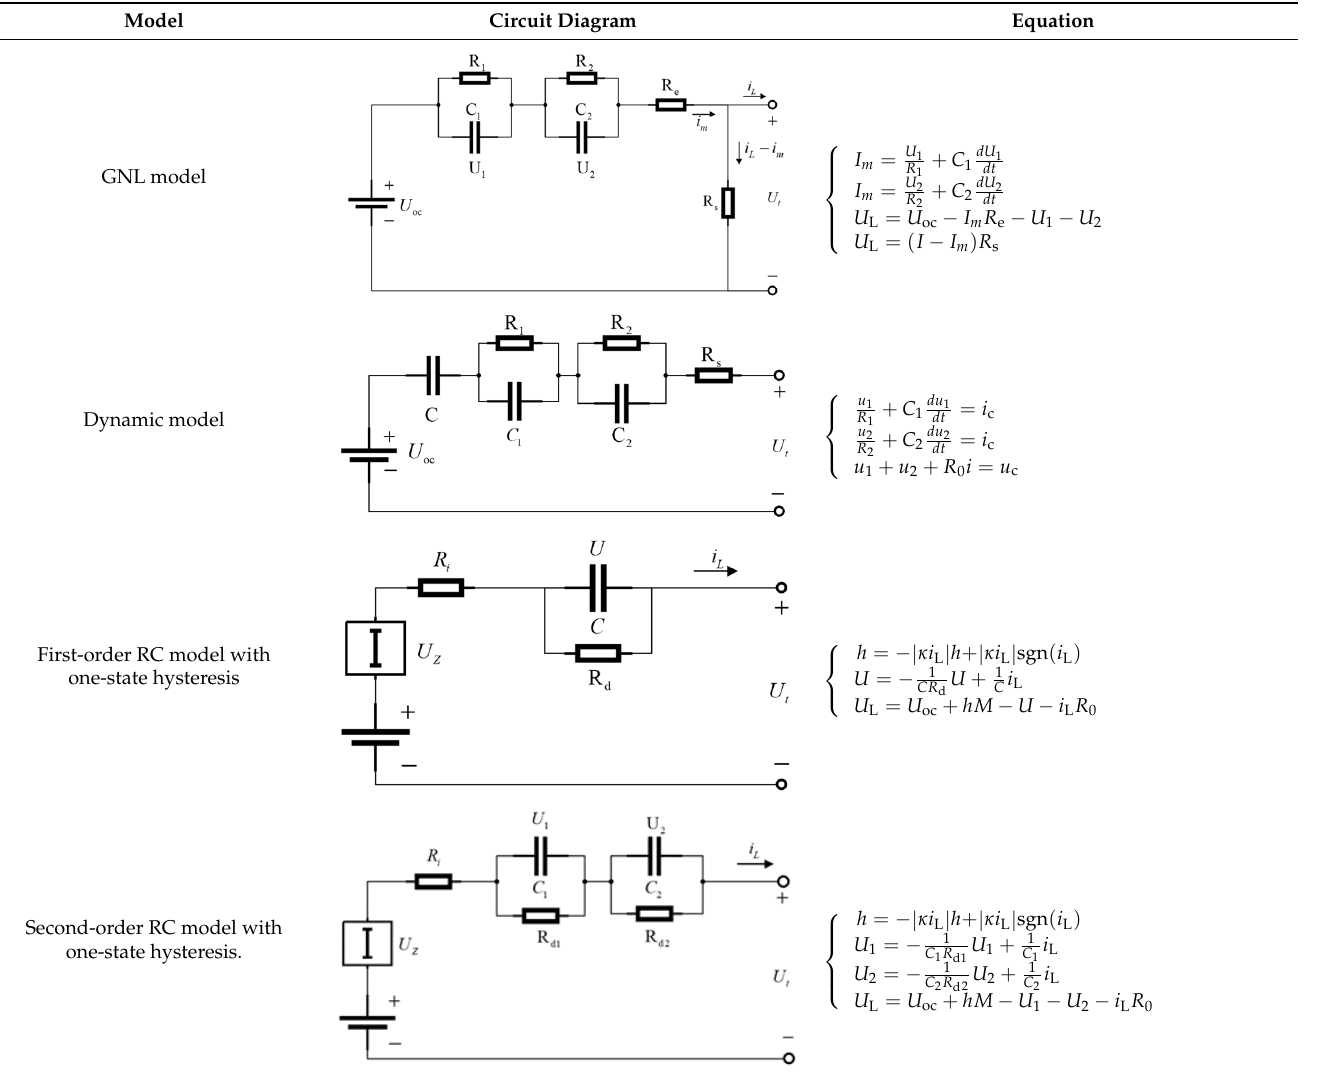
Table 2. Parameter identification results of Thevenin model for